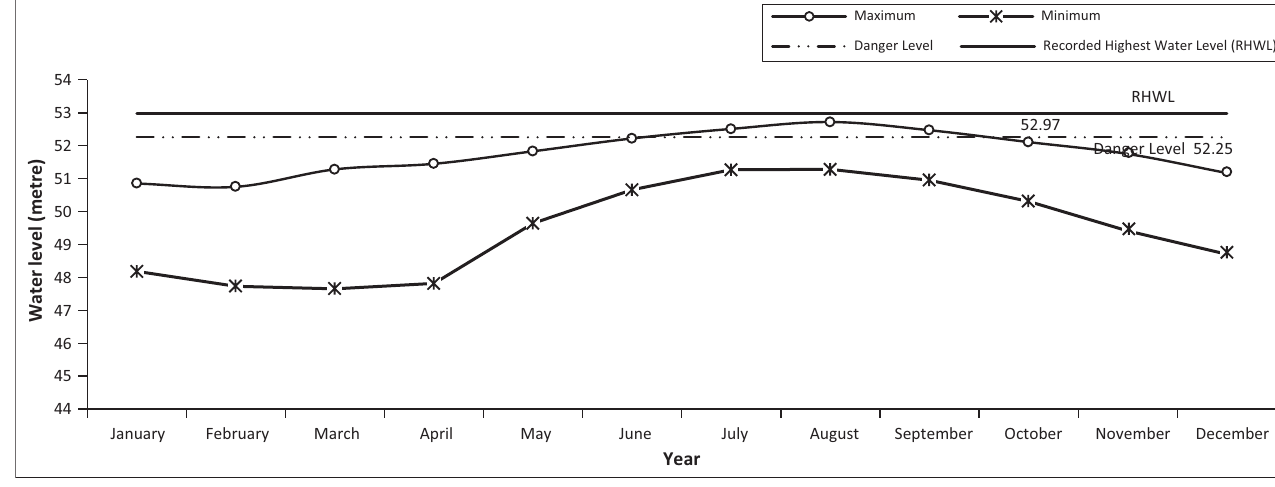
FIGURE 11: Monthly recorded maximum and minimum water level at Dalia station from 1985 to 2006.